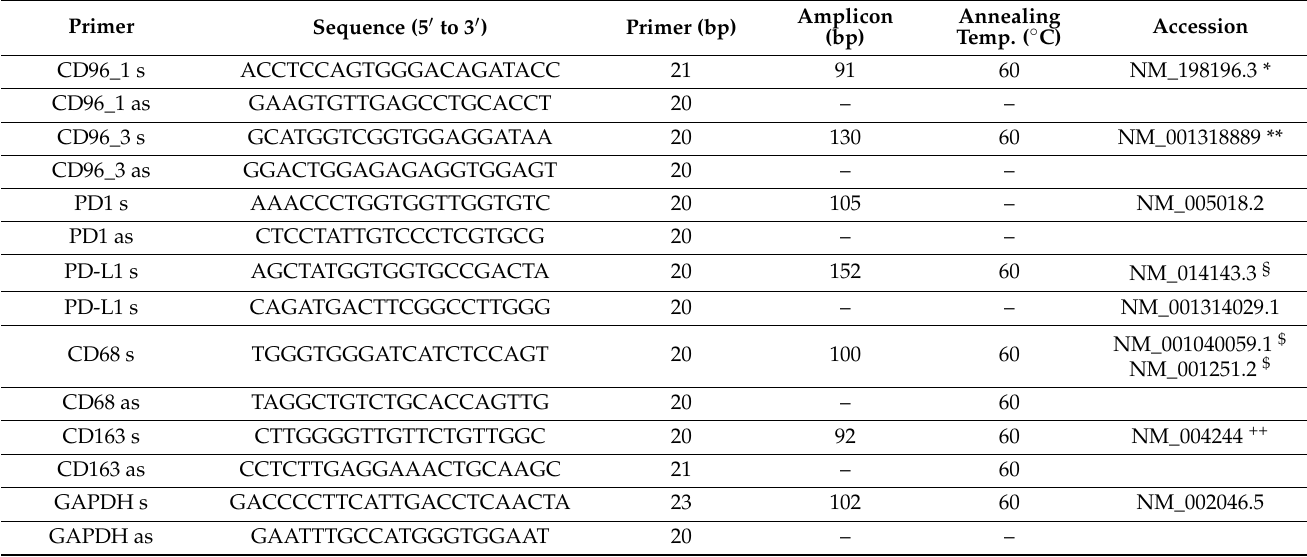
Table 2. Real-time qPCR primer. The table shows selected primers for RT-qPCR mRNA expression analysis of PD1, CD96_1, CD96_3, PD-L1_4, GAPDH, CD68, and